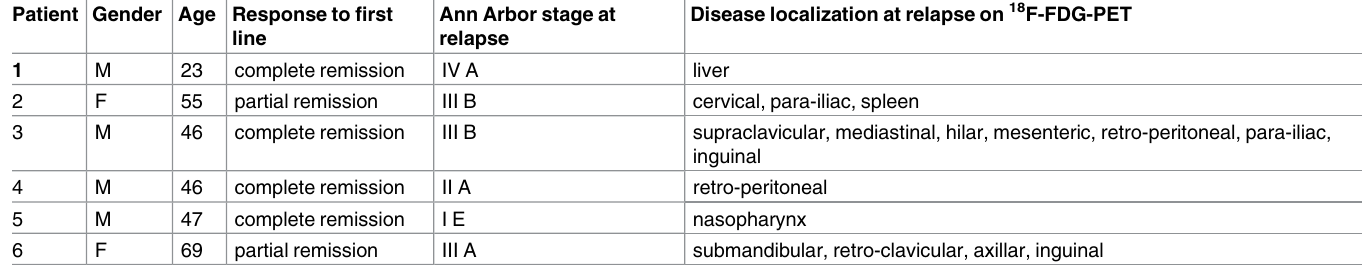
Table 1. Patient characteristics.